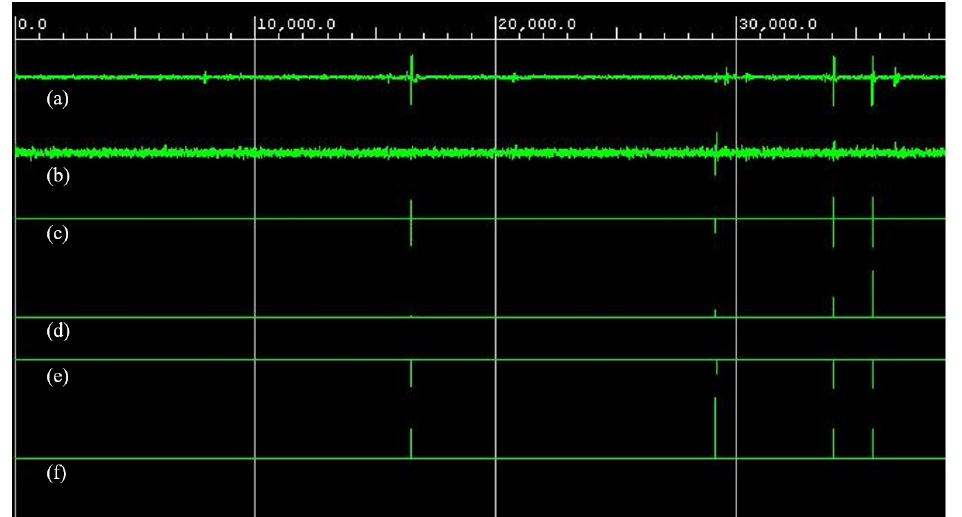
Figure 10. Waveforms from the single-channel unfiltered input system: ( a ) the input signal (Signal_In), ( b ) filter output (internal signal), ( c ) output wave during neural activity (Op_Wave), ( d ) timestamp (Op_Time) and ( e ) peak amplitude (Op_Amp).